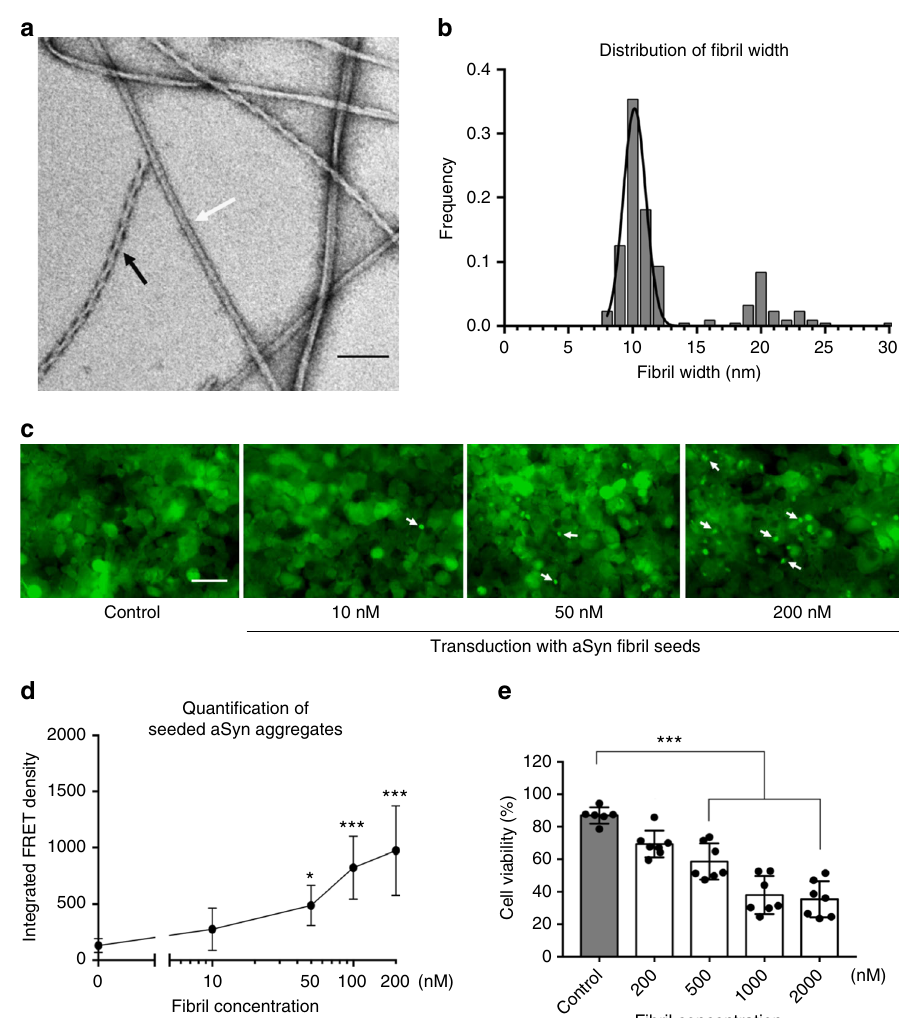
Fig. 1 aSyn fi brils with distinct polymorphs have in vitro seeding and toxicity in cells. a , b Negative-stain EM ( a ) of full-length aSyn fi brils showing two distinct polymorphs — rod (non-twisted fi laments, white arrow) and twister (twisted fi laments, black arrow) — and a fi bril width around 10 nm ( b ). c , d Direct visualization ( c ) and FRET-based quanti fi cation ( d ) of seeded intracellular aSyn aggregates. Fluorescent images obtained using the FITC channel (ex. 488 nm, em. 525 nm) showed aSyn aggregates as indicated by bright fl uorescent puncta (white arrows in c ). The diffuse background fl uorescence came from endogenously expressed soluble, non-aggregated YFP-aSyn in the cells. Transduction of sonicated aSyn fi bril seeds into the cells induced intracellular aSyn aggregation, which was also quanti fi ed using FRET analysis ( d and Supplementary Fig. 3). e Cytotoxicity of aSyn fi brils evaluated by MTT-based cell viability assay of differentiated PC12, neuron-like cells. The aSyn fi brils used in the seeding experiment ( c , d ) have signi fi cant cytotoxicity ( p < 0.0001) at 500 nM. Data are presented as mean ± standard error. Results are from multiple independent biological experiments with n = 3 – 5 per experiment. * p ≤ 0.01, *** p ≤ 0.0001 vs. control (buffer used to produce the aSyn fi brils). Scale bar: (a) 100 nm (c) 50 μ